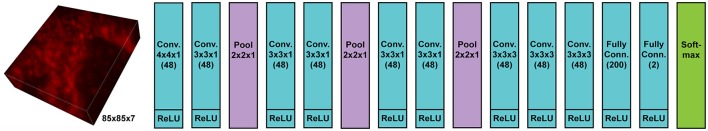
Architecture of 3-D convolutional neural network for boundary detection. The network has nine convolution layers, three max-pooling layers, two fully-connected layers, and a softmax layer. Rectified linear unit (ReLU) was used as the activation function.